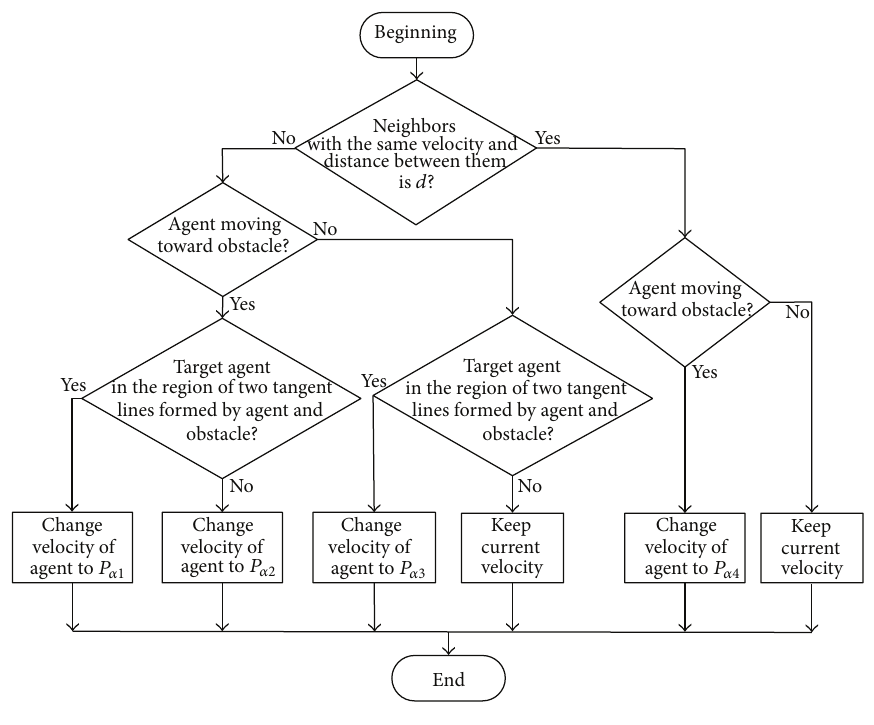
Figure 5: The workflow of FMOA